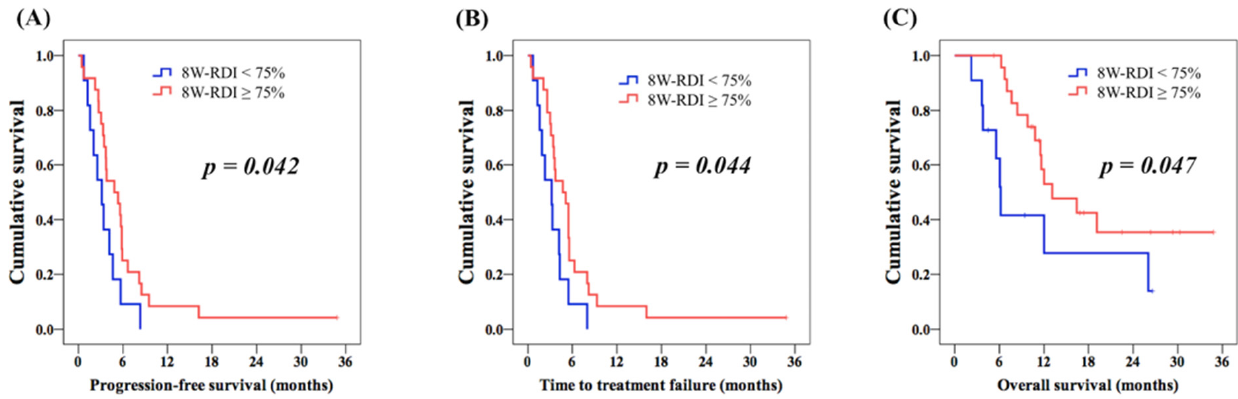
Figure 3. Kaplan–Meier survival curves comparing progression-free survival (PFS), time to treatment failure (TTF) and overall survival (OS) between patients with 8W-RDI ≥ 75% or 8W-RDI < 75%. ( A ) PFS, ( B ) TTF and ( C ) OS.